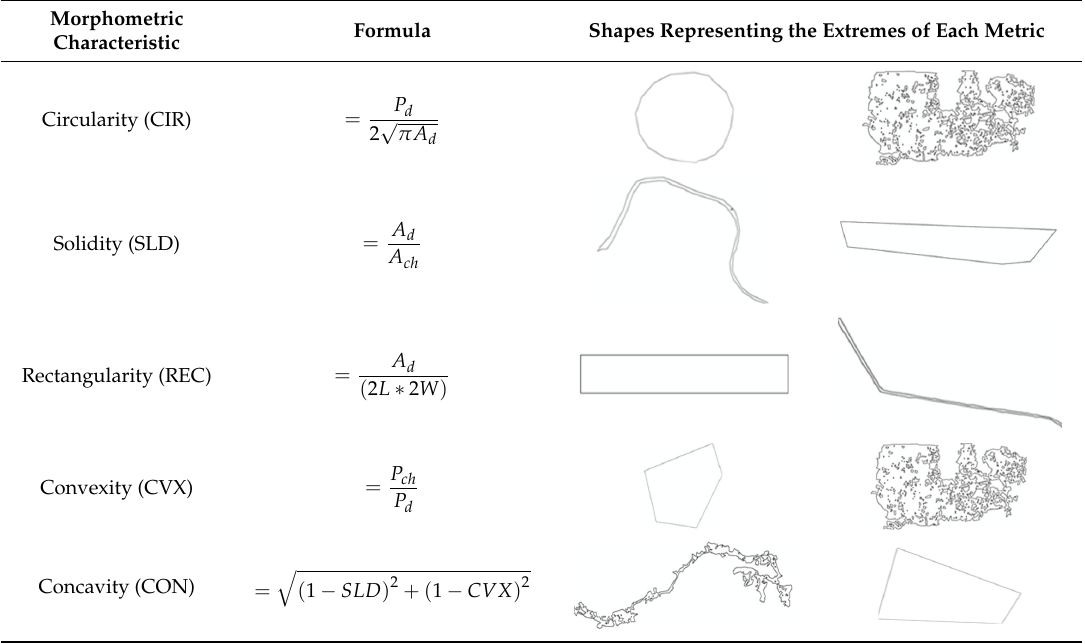
Table 1. Morphometric features calculated for each depression to characterize its shape. Circularity (CIR) compares the shape to a circle; values approaching 1 indicate a more circular depression. Solidity describes the extent to which a shape is concave or convex. Rectangularity compares how closely the depression resembles a rectangle. Concavity is the extent that a shape is